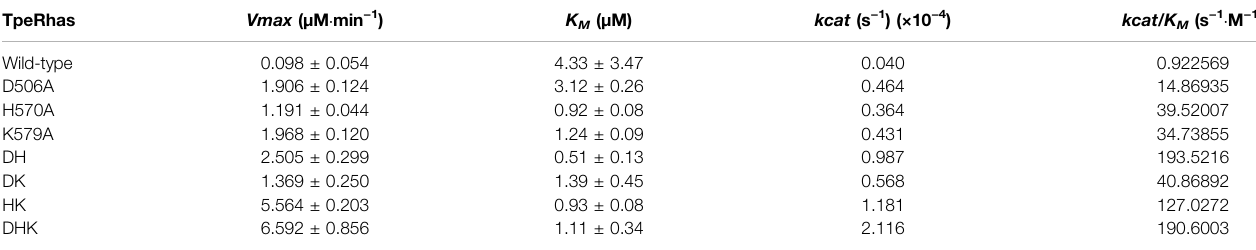
TABLE 2 | Kinetic parameters of the TpeRha mutants against icariin. TpeRhas